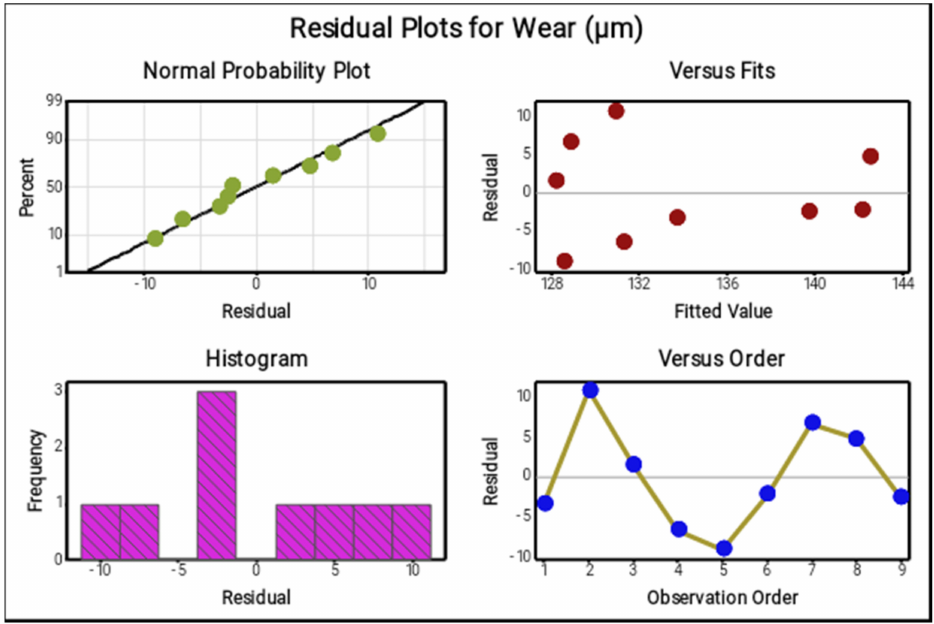
Figure 12. Residual plots for wear.